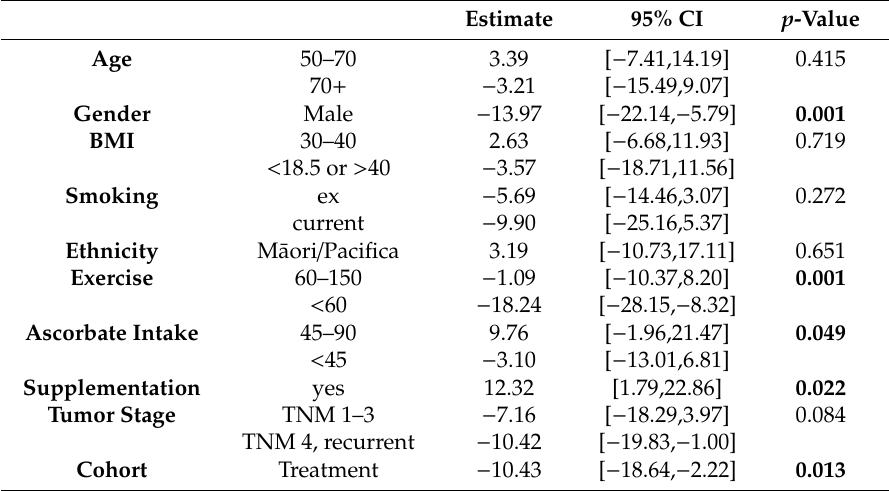
Table 3. Univariate e ff ects of patient characteristics on plasma ascorbate.